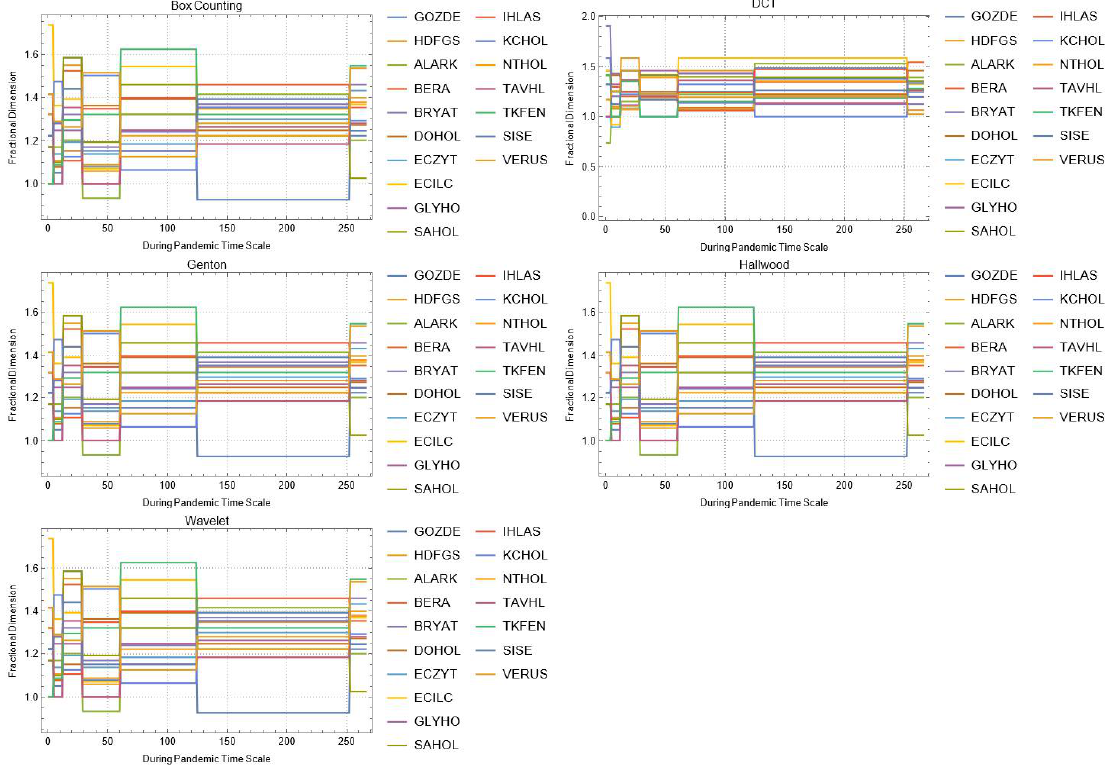
Figure A11. Daily changes of fractal dimensions during the pandemic (holdings–investment companies).